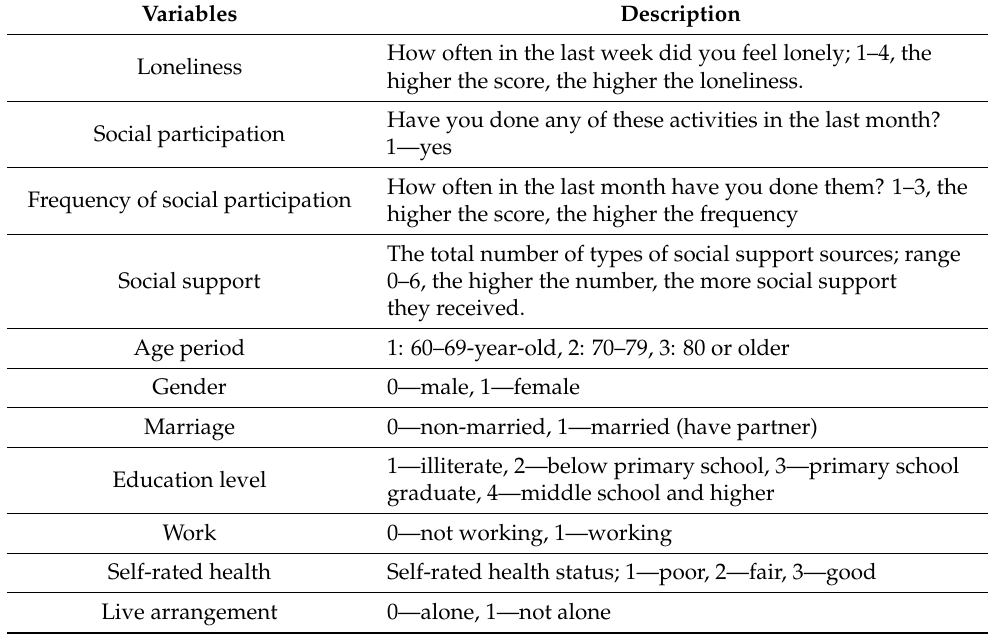
Table 1. Informationaboutvariables’properties: numberofitems, responseoptions, andcodingprocedure.